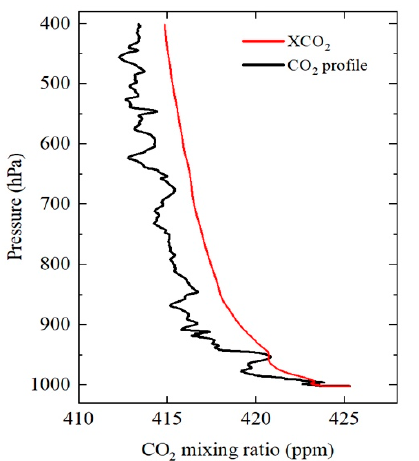
Figure 6. In situ profiles for CO 2 during the vertical spiral maneuvers.